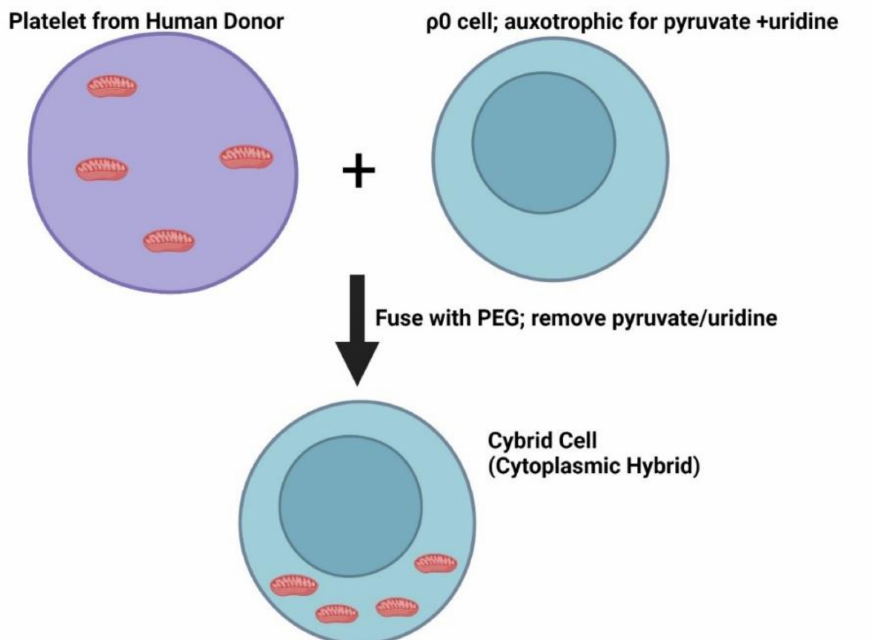
Figure 2. Cytoplasmic Hybrids (Cybrids). Patient-derived platelets with mitochondria are fused with cells that lack mtDNA ( ρ 0 cells) using PEG (polyethylene glycol). The ρ 0 cells are auxotrophic for pyruvate and uridine. After fusing platelets with ρ 0 cells, pyruvate and uridine are withdrawn to select for cells that received